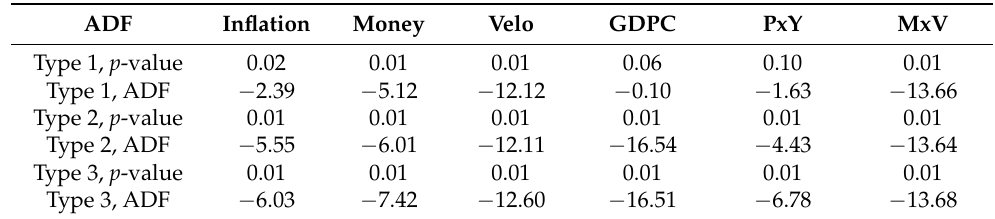
Table 1. ADF unit root test, lag = 0. Type 1: no drift, no trend. Type 2: with drift, no trend. Type 3: with drift and trend.